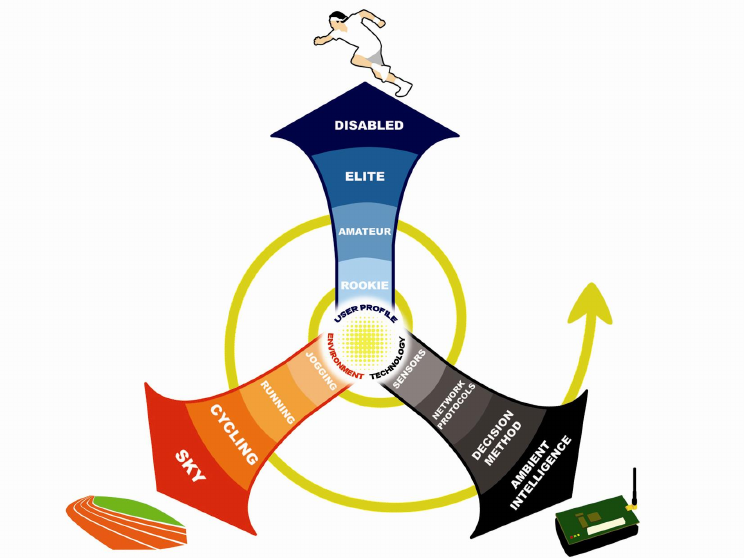
Figure 1. General vision of ambient intelligence aimed at